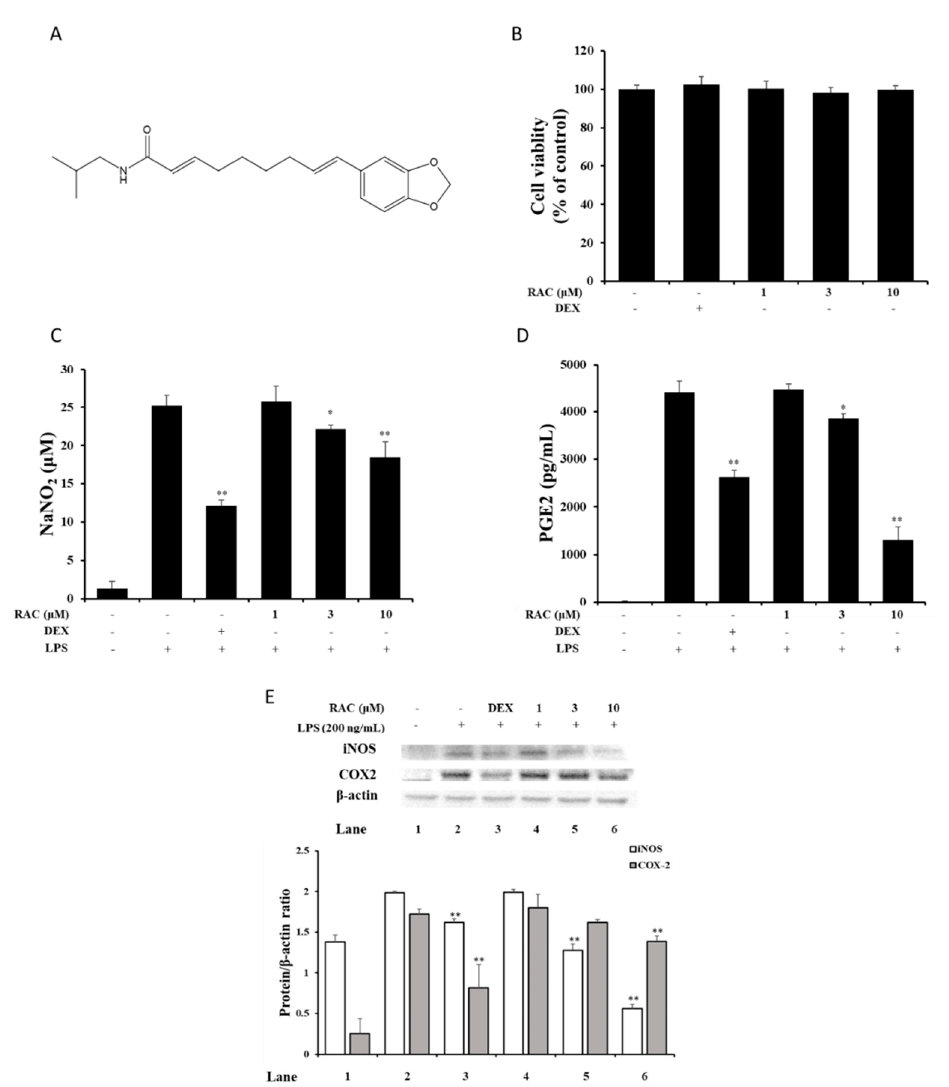
Figure 1. Inhibitory e ff ect of retrofractamide C (RAC) on lipopolysaccharide (LPS)-induced nitric oxide (NO) and PGE2 production and iNOS and COX2 protein expression in J774A.1 cells. ( A ) Chemical structure of retrofractamide C (RAC). ( B ) Cytotoxicity of RAC. J774A.1 cells were treated with the indicated concentrations of dexamethasone and RAC for 24 h. Cytotoxicity was determined by MTT assay. ( C , D ) Inhibition of NO and PGE2 production by RAC. J774A.1 cells were pretreated with 10 µ M dexamethasone or 1, 3 or 10 µ M RAC for 1 h before treatment with 200 ng / mL LPS for 18 h. ( C ) The secretion of NO was measured by an NO assay. ( D ) PGE2 production was determined by ELISA. ( E ) iNOS and COX2 protein expression decreased by RAC treatment. J774A.1 cells were treated with 200 ng / mL LPS for 18 h after treatment with dexamethasone and RAC for 1 h. The iNOS and COX2 protein expression levels were determined by immunoblot assay. The band optical densities were calculated by ImageJ software. Representative data are presented. Values are presented as the mean ± SD of three individual experiments. * p < 0.05, ** p < 0.01 compared with the LPS only-treated group. DEX, 10 µ M dexamethasone.